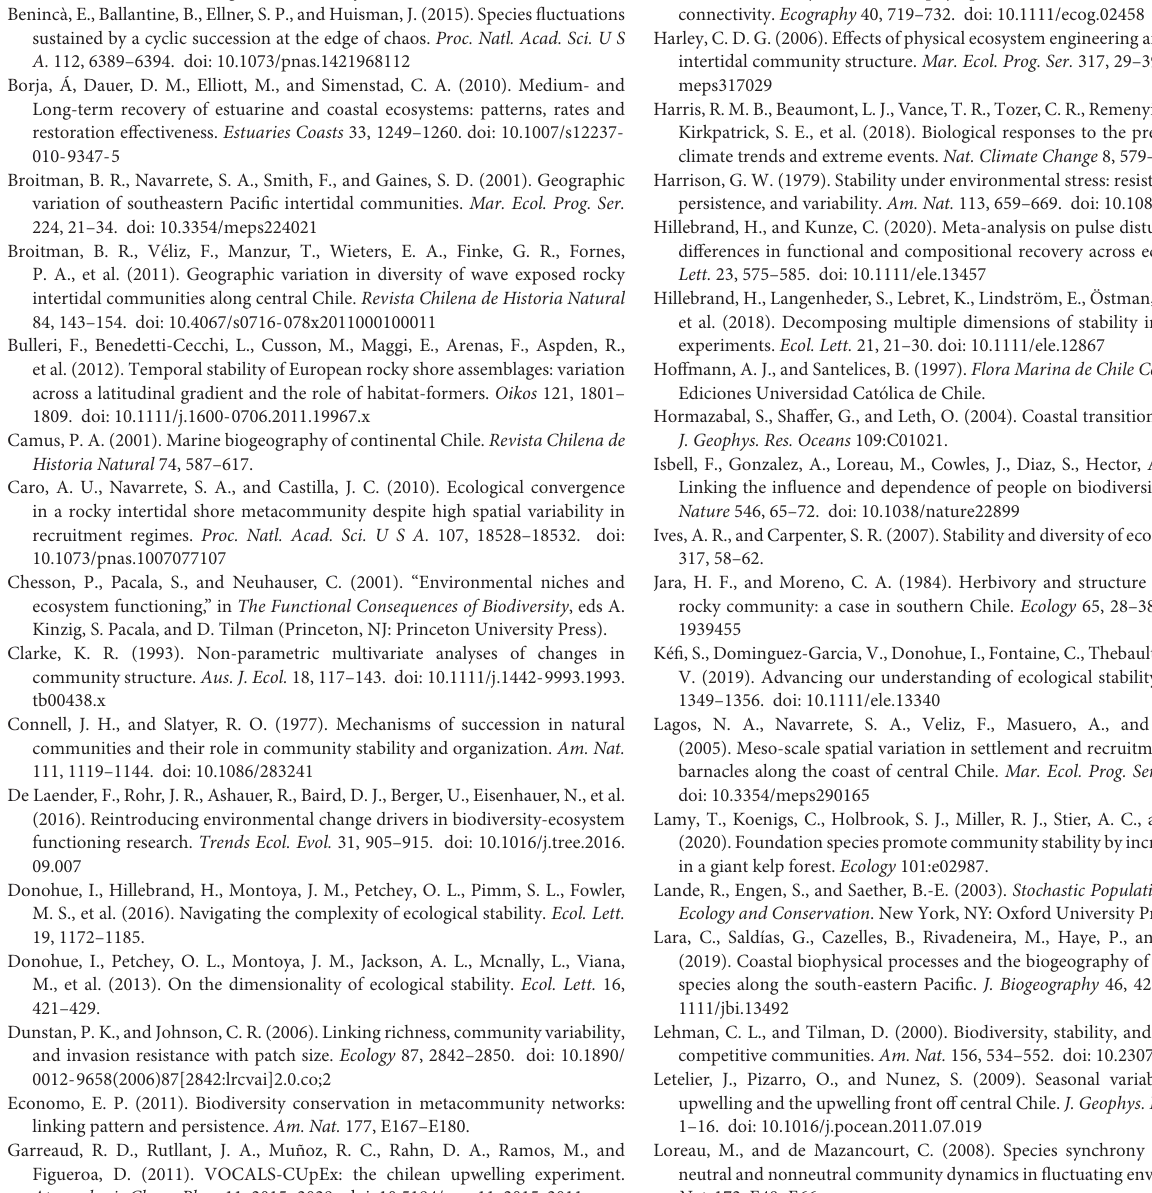
Figueroa, D. (2011). VOCALS-CUpEx: the chilean upwelling experiment. Atmospheric Chem. Phys. 11, 2015–2029. doi: